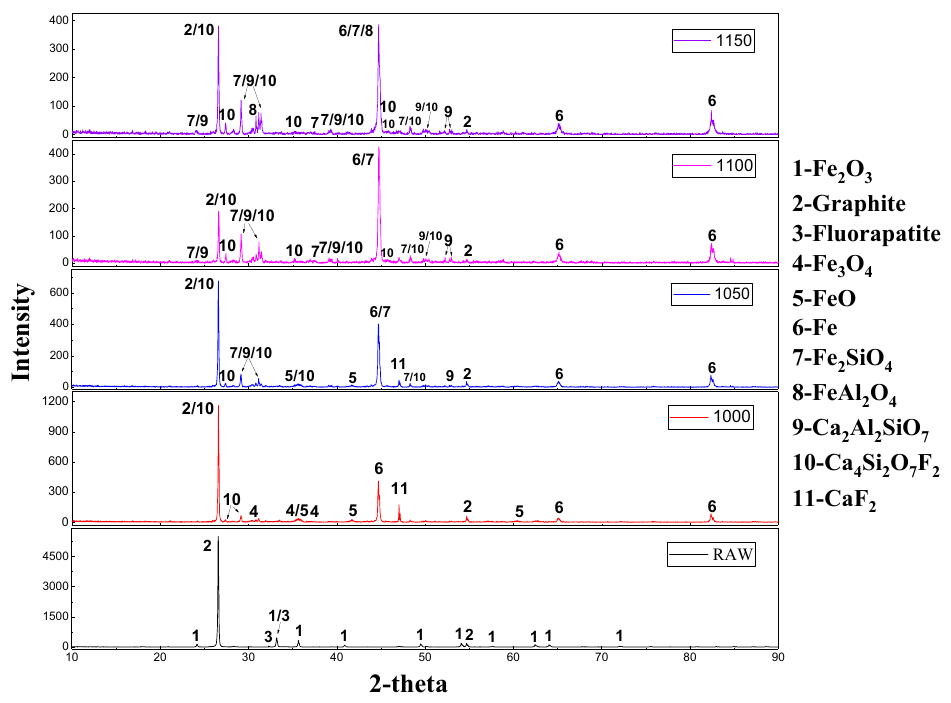
Figure 3. X-ray diffraction (XRD) spectra of reduced pellets at different temperatures.